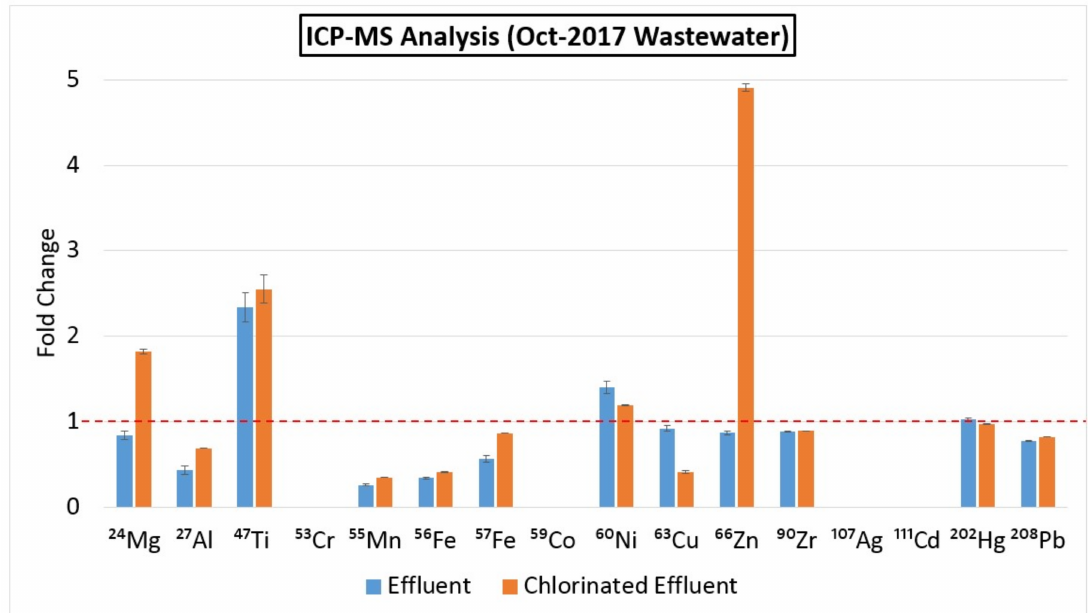
Figure 6. Fold Change of Metal Concentration in the effluent and chlorinated effluent in October 2017. Fold changes are measured with respect to the concentration in the influent. A fold change value of 1.0 implies no change (red dashed line). The numbers in superscript denote the atomic mass of the metal. Raw values of each ion as measured by ICP-MS are listed in Table